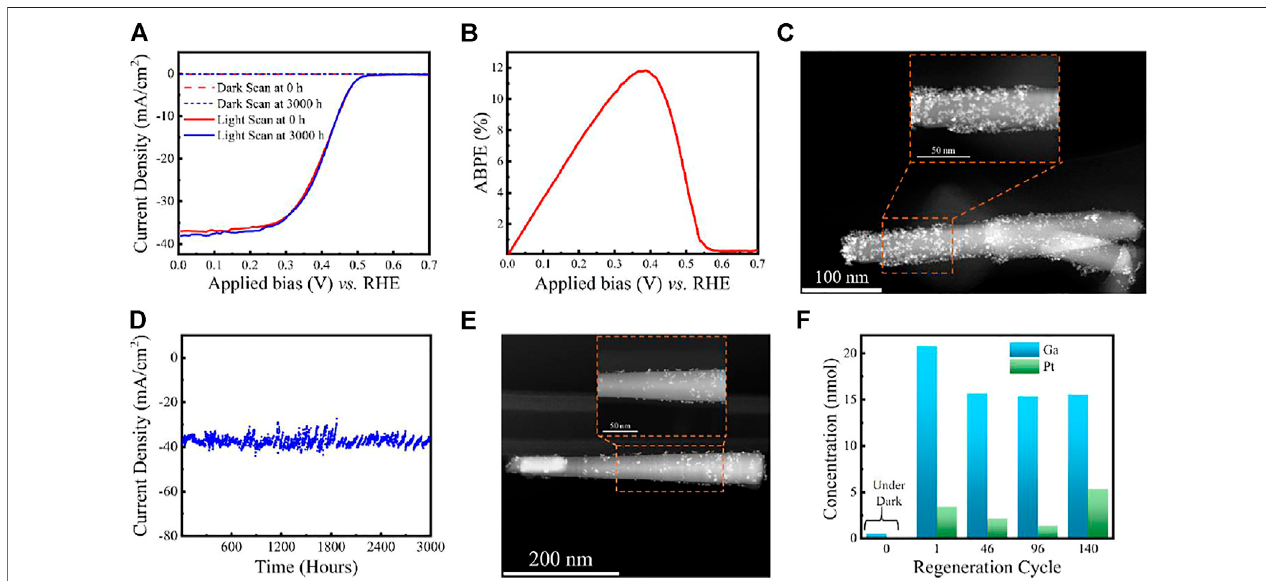
FIGURE 5 | (A) LSV comparison of GaN/Si photocathode before and after 3,000 h stability experiments. (B) ABPE of Pt decorated GaN/Si photocathode before stabilityexperimentsin0.5 MH 2 SO 4 underAM1.5Gone-sunillumination. (C) STEMimageofPtdecoratedGaNnanowirebeforestabilityexperiment. (D) Ultra-longterm stabilityexperiments usingGaN/Siphotocathode undercontinuous AM1.5Gone-sunillumination. (E) STEMimage ofPtdecoratedGaNnanowireafter 3,000 hstability experiments. (F) ICP-MS measurements of liquid samples at different runs during the experiment. Reprinted (adapted) with permission from Vanka et al. (2019). Copyright 2019 Royal Society of